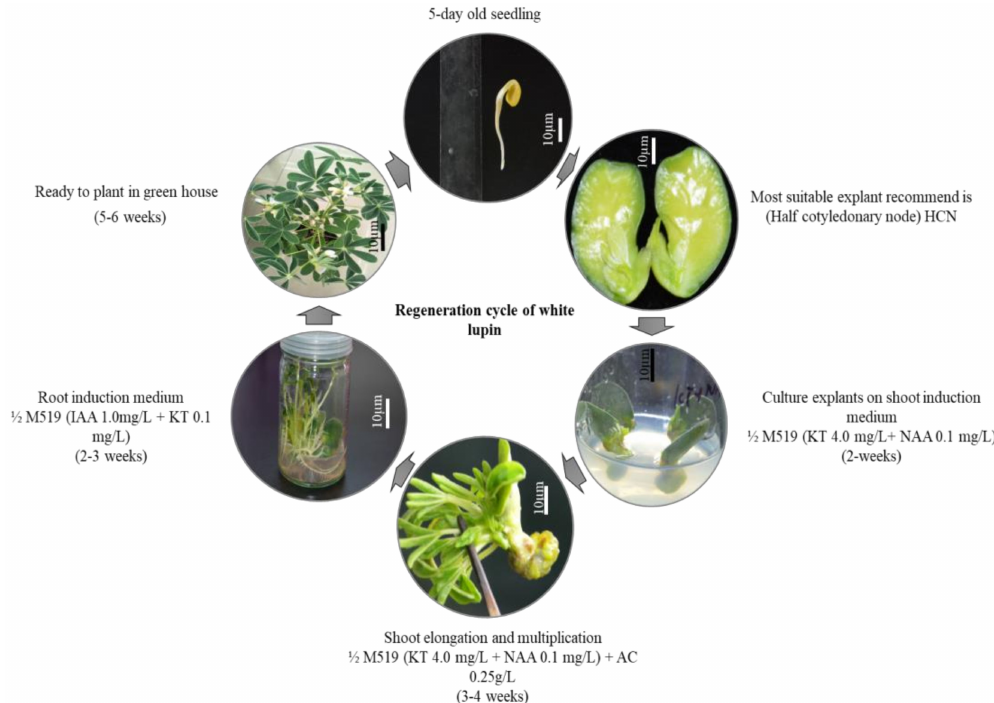
Figure 7. Full regeneration cycle of Lupinus albus . Di ff erent steps of direct regeneration are shown with their timelines. The regeneration cycle from cotyledons to seed collection takes ~18 weeks. It can be shortened by another two weeks by skipping the shoot elongation step and increasing the shoot initiation medium incubation for three weeks (light arrow) (Shoot initiation medium; shoot elongation medium; root induction medium). Table 1. E ff ect of di ff erent concentrations of plant growth regulators on in vitro generated shoot multiplication on 1 M519 medium by using HCN as an explant. Di ff erent alphabetic letters show 2 significant di ff erences among all combinations used for shoot regeneration in white lupin. E ff ect of Di ff erent Concentration of Length of Shoot Plant Growth Regulators on Shoot after 14 Regeneration (mg / L)